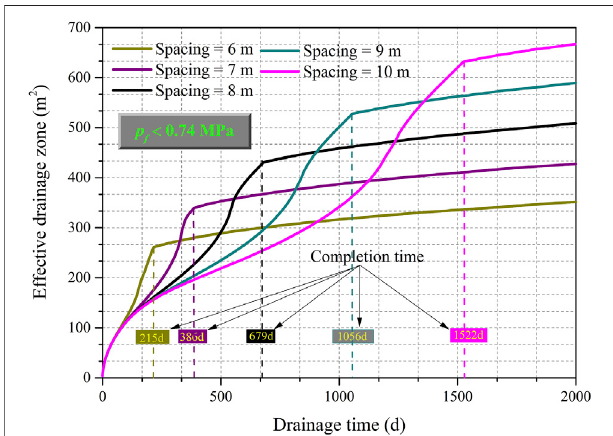
FIGURE 8 | Effective drainage zone sizes around tree-type boreholes at different spacings for 0 – 2000 d gas extraction. Completion times (methane pressure < 0.74 MPa) for each borehole spacing are also shown.